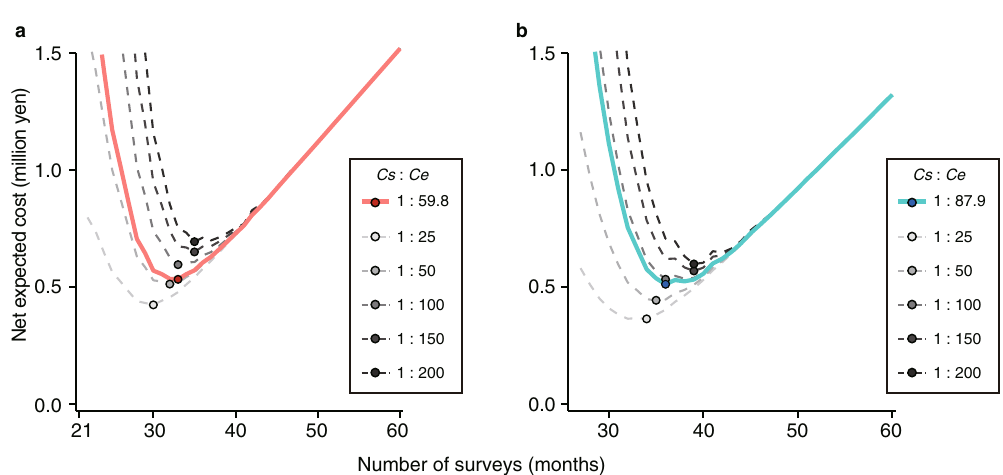
Figure 3. The net expected cost of declaring eradication versus the number of months after the last ant sighting (solid coloured curves) if management continued as usual, but no more ants were detected. The current monthly cost of management ( Cs ) is JPY 40,000, and we assumed that the costs of declaring eradication were 59.8 and 87.9 times the monthly monitoring cost at ( a ) Tokai and ( b ) Jonan, respectively. The dotted lines indicate results for 5 different cost